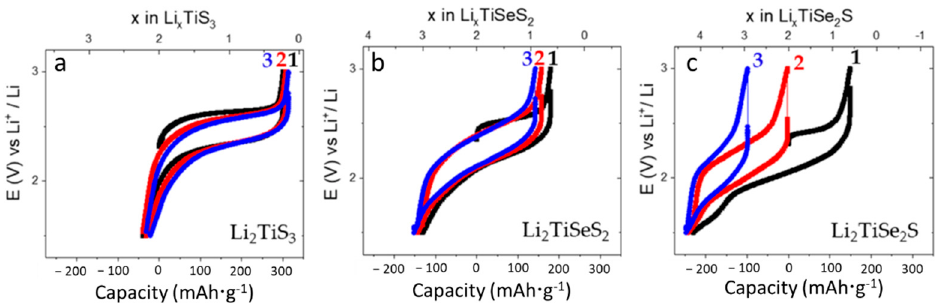
Figure 4. Galvanostatic curves of ( a ) Li x TiS 3 , ( b ) Li x TiSeS 2 , and ( c ) Li x TiSe 2 S cathode materials in half-cell at a rate of C/10 between 3 and 1.5 V vs. Li + /Li, the first three cycles were represented in the figures.